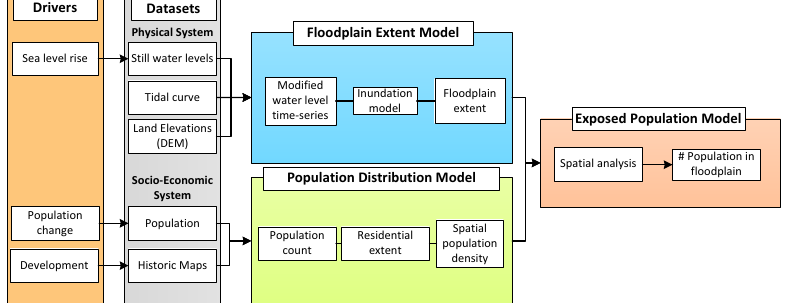
Figure 3. Methodology for evaluating changes to flood